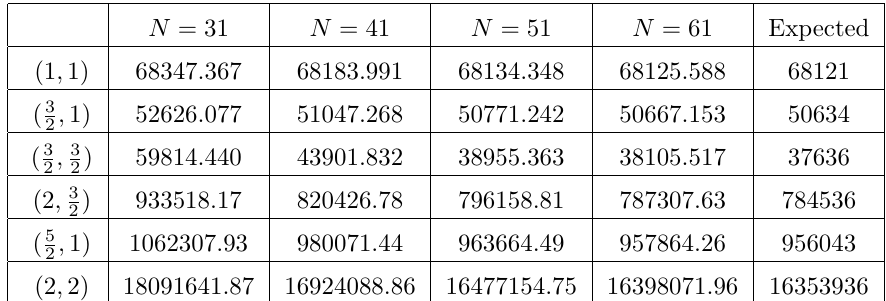
Figure 8 . The extremal functional method applied to the c = 9 putative CFT. The scalar spectrum (left) and spin-one spectrum (right) are presented.